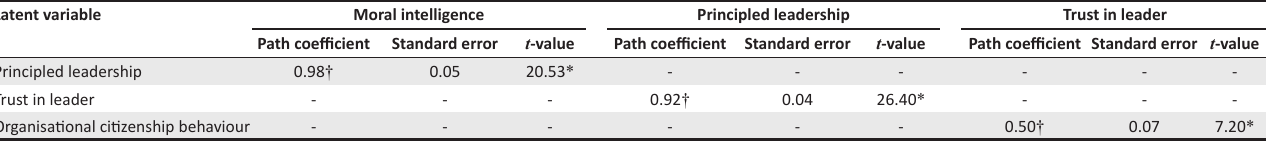
TABLE 4: Gamma and beta matrix of the structural model’s path